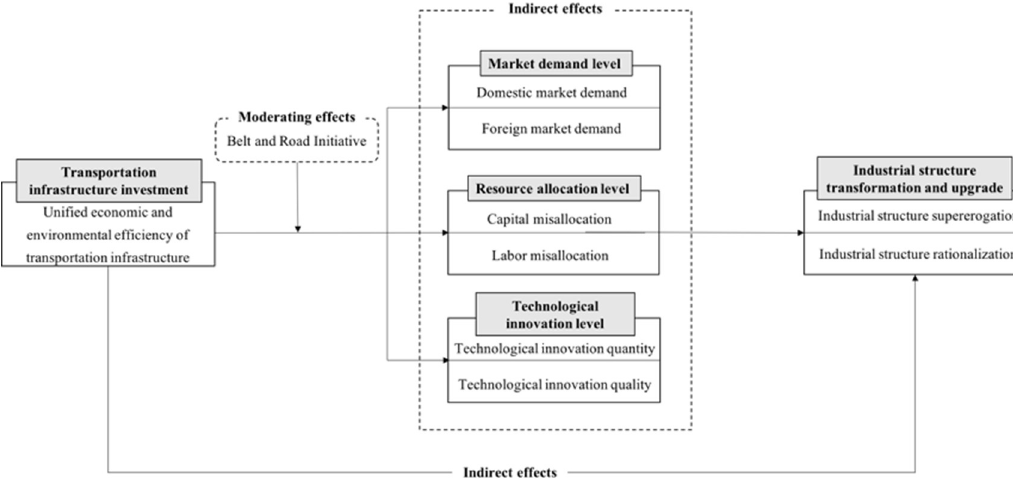
Fig 1. Mechanism of the unified economic and environmental efficiency of transportation infrastructure influencing industrial structure transformation and upgrade.